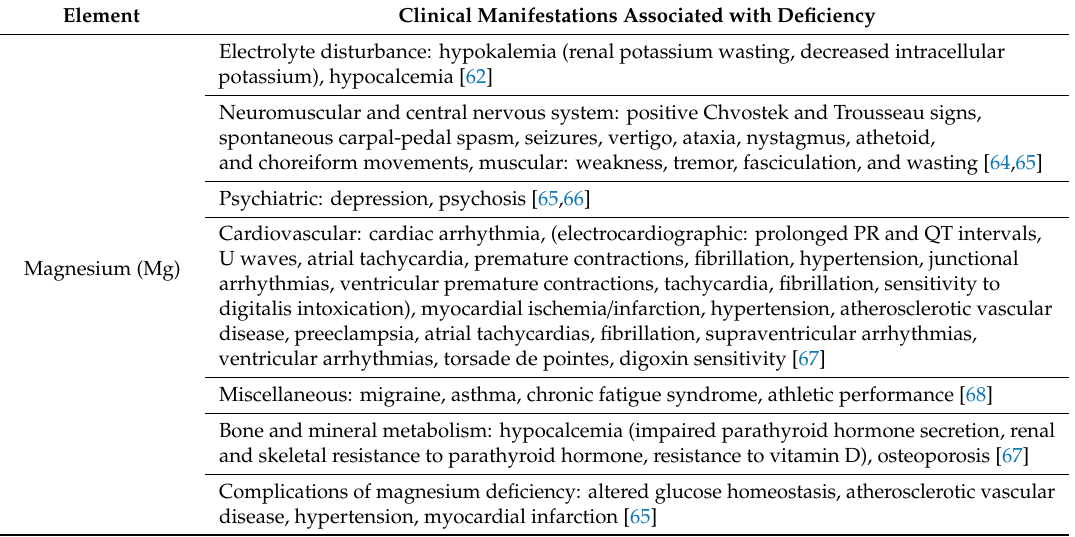
Table 2. Clinical features of minerals deficiency (hypocalcemia, hypomagnesemia, hypophosphatemia, hyponatremia, and